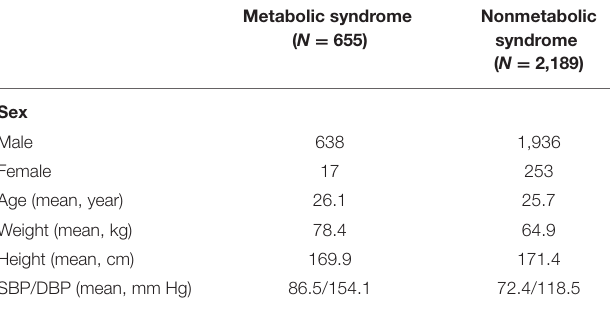
TABLE 2 | Basic characteristics of the